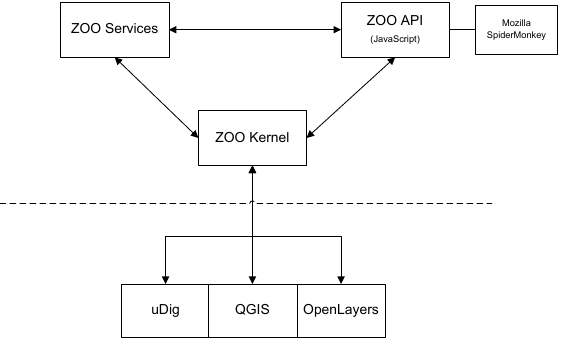
Figure 2. Depicts the architecture of the ZOO framework, adapted from http://www.zoo-project.org/ The ZOO service provider consists of the Service Shared Object (SSO) and a metadata ZOO configuration file (.zcfg) per provided service (Fenoy et al ., 2010). This facilitates the GetCapabilities and DescribeProcess request specified in the WPS 1.0.0 standard specification. The kernel parses the